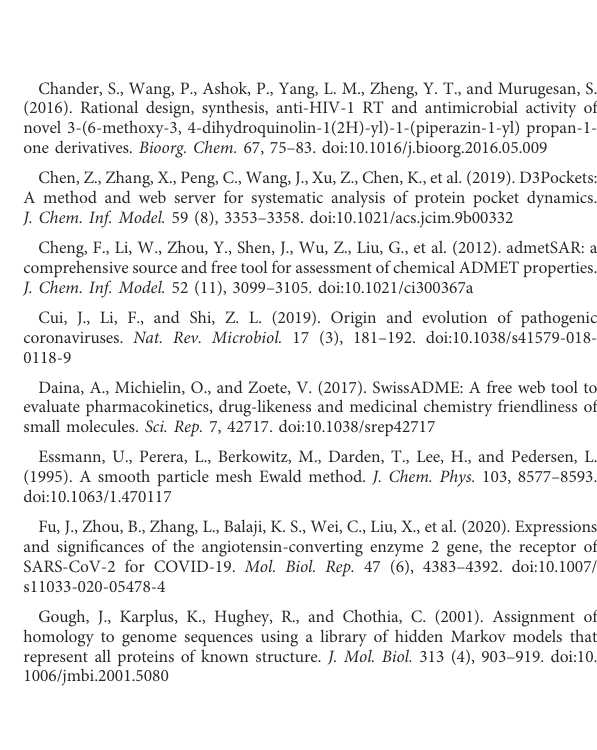
SUPPLEMENTARY FIGURE S4 Figure showing the graphs of Radius of gyration of complexes of Domain 3 with molecules (molecules ZINC000103666966, ZINC000020413317, and ZINC000030883119) at 200 ns time point. SUPPLEMENTARY FIGURE S5 Figure showing the graph of SASA of complexes of Domain 3